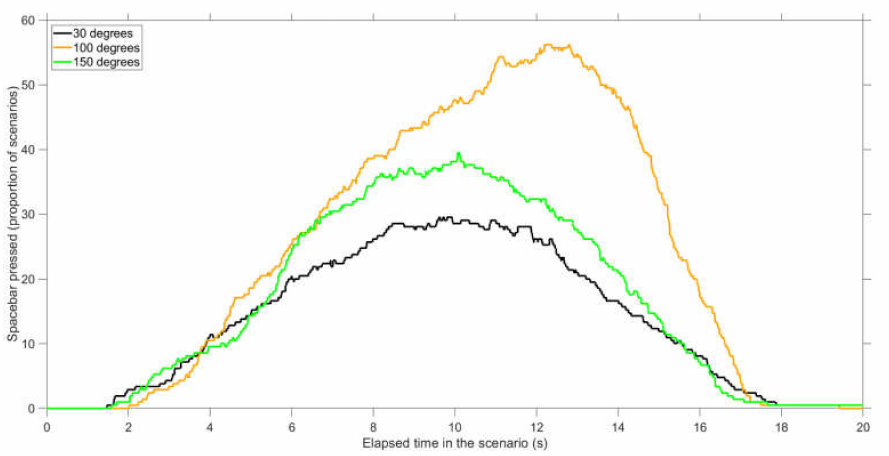
Figure 4. Percentage of participants who pressed the spacebar at that point in time during the scenario, for non-conflict scenarios. The proportion is calculated for 210 scenarios (35 participants × 6 scenarios per conflict angle).